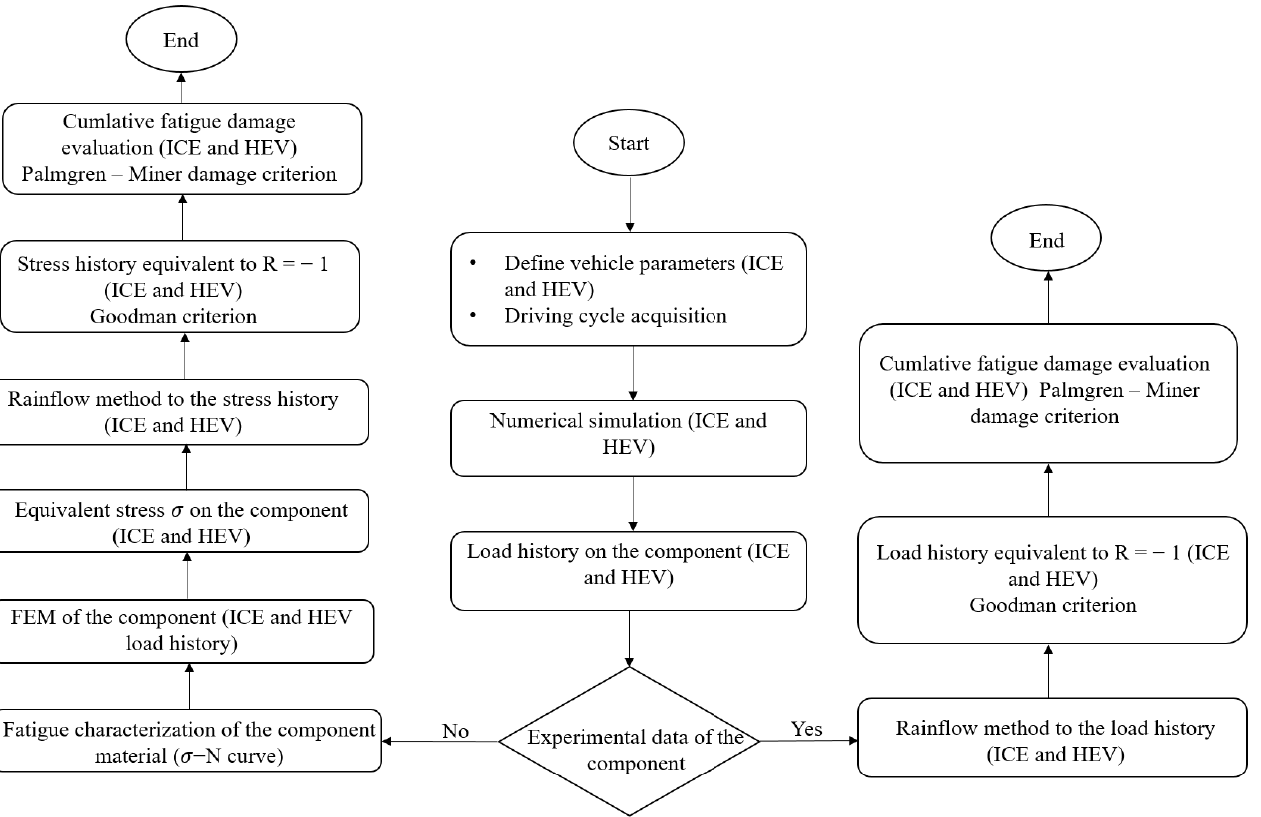
Figure 1. Workflow adopted for the evaluation of the cumulative fatigue damage of the component. It is possible to choose two different workflows, depending on the availability of the experimental data of the component.